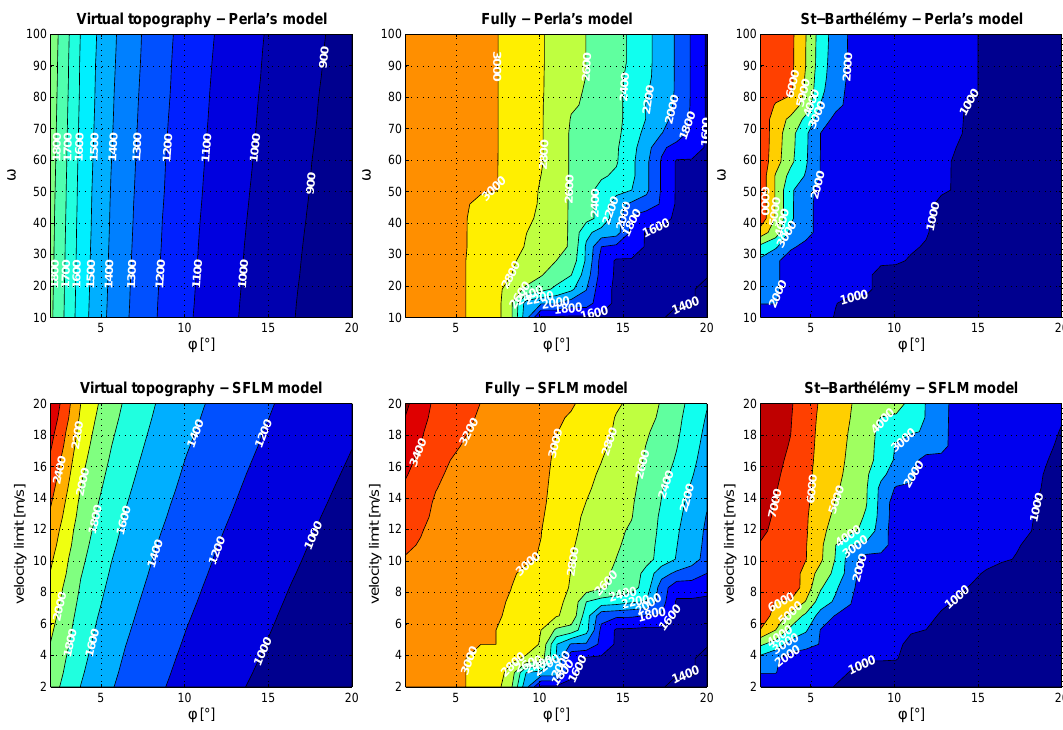
Fig. 14. Effect of the parameters of both algorithms for energy assessment on the runout distance for the virtual topography, Fully and Saint-Barth´el´emy case studies, Switzerland.